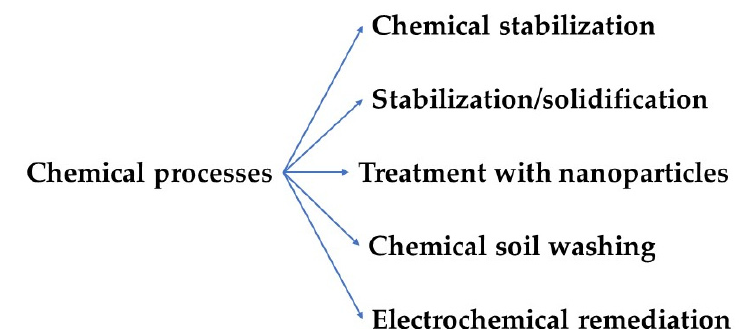
Figure 3. Chemical processes to remove heavy metals and metalloids.